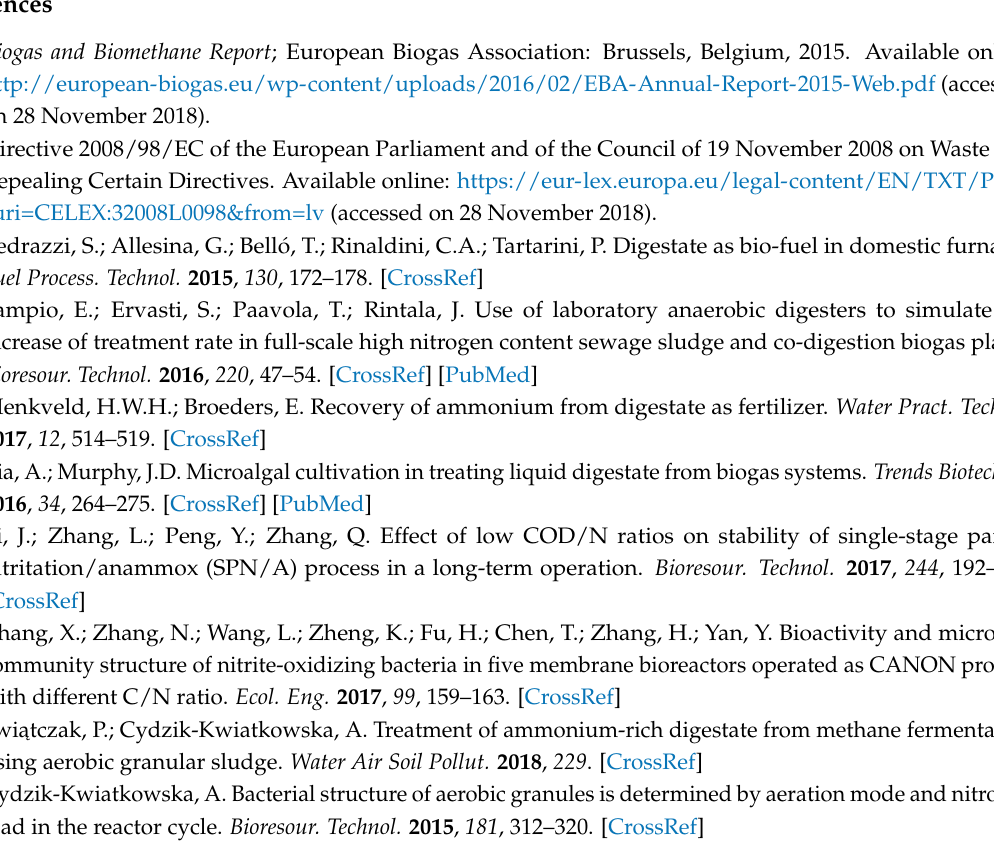
Figure S1: Kinetics of COD removal in the cycle of GSBR 6h (a), GSBR 8h (b) and GSBR 12h (c), Figure S2: Bacterial taxa in granular